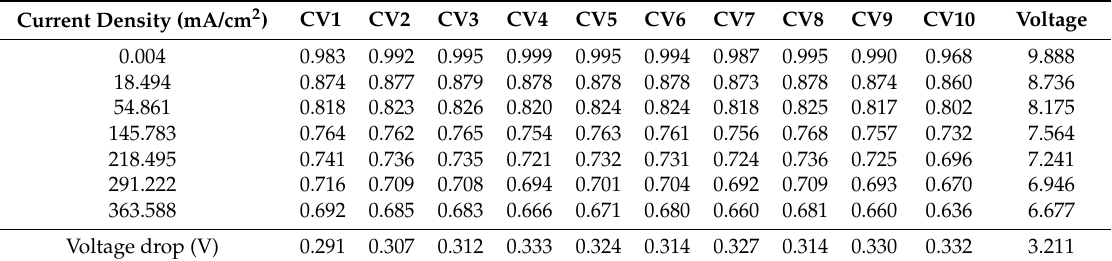
Table 5. Dynamic performance at different relative humidities (85%).